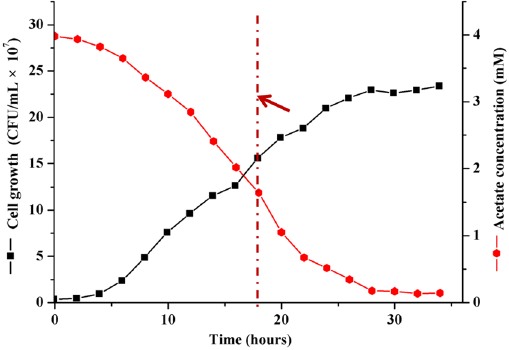
Figure 4. Growth curves of Acinetobacter sp . DW-1. Cells were grown at 30 °C in MSM with 4 mM acetate as the sole carbon and energy source. Growth was followed using the plate counting method. Cells were harvested from cultures for subsequent experiments after 18 h incubation (red arrow).